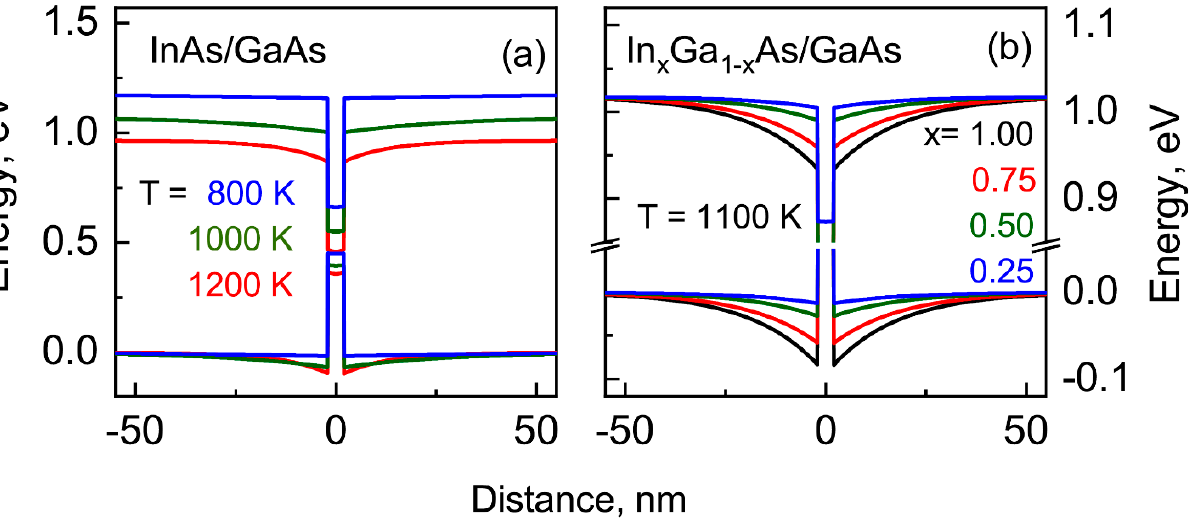
Figure 6. Band diagrams of heterostructures with the (In,Ga)As/GaAs QW calculated for ( a ) the InAs QW as a function of temperature and ( b ) an In x Ga 1 − x As QW as a function of composition x at T = 1100 K .